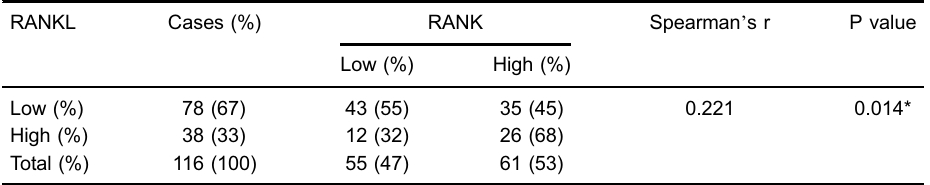
Table 2. Spearman ’ s correlation between RANKL and RANK expression in primary gastric cancer patients.